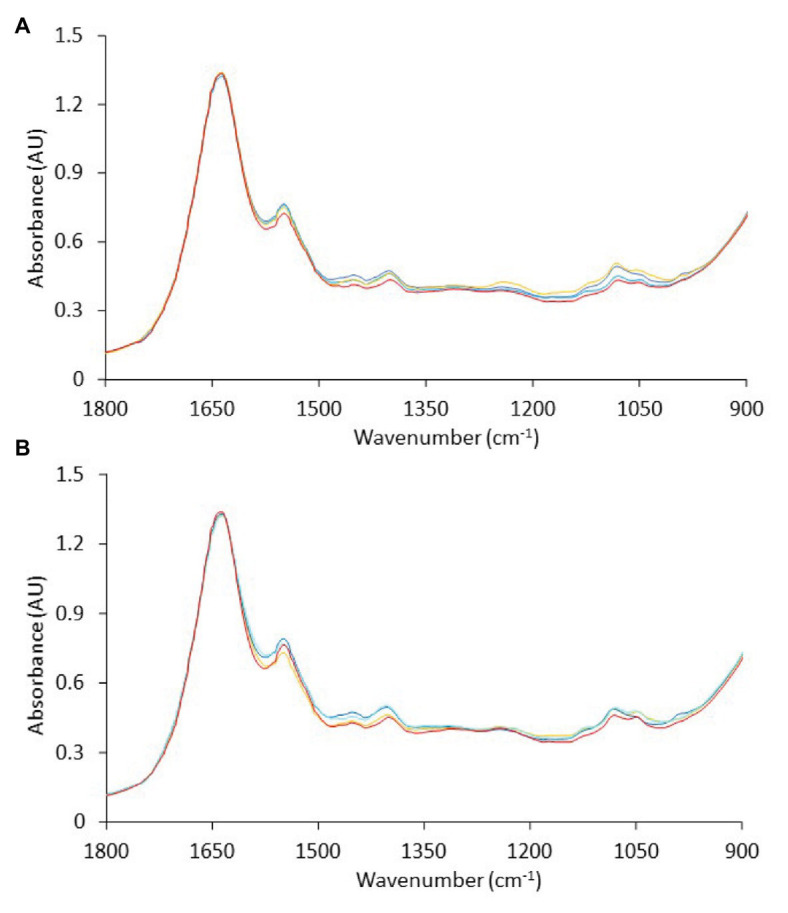
Representative Fourier-transform infrared spectra, in the wavenumber range of 1,800 to 900 cm−1, corresponding to (A) non-inoculated and (B) inoculated-with-Salmonella chicken liver samples at the beginning (, 0 h) and at the end of aerobic storage at 0°C (, 240 h), 4°C (, 192 h), and 8°C (, 128 h).